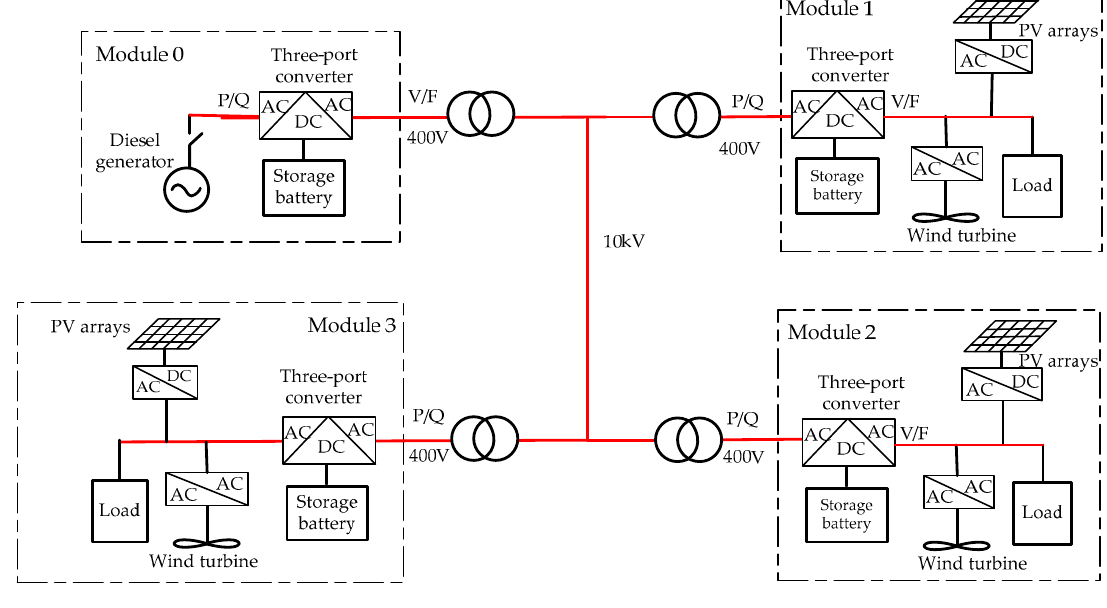
Figure 2. Structure of modular microgrid on DongAo Island.